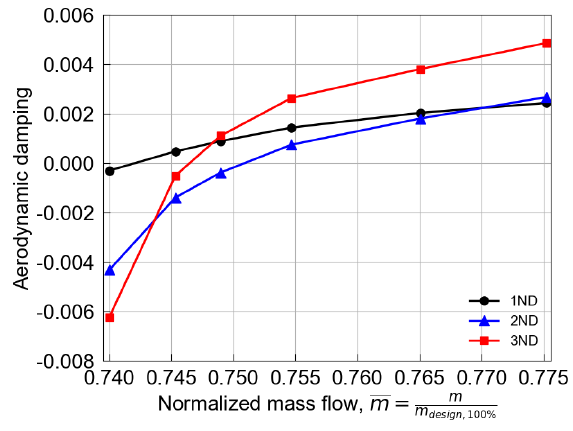
Figure 14. Aerodynamic damping versus mass flow.